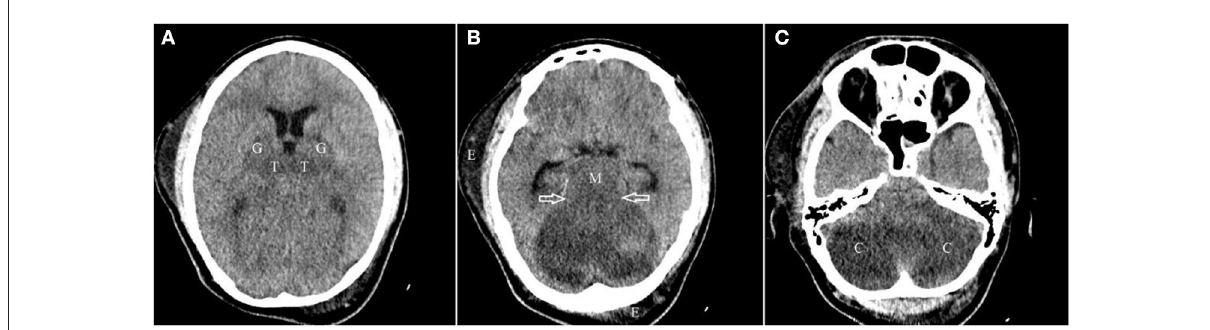
FIGURE1 Axial images of non-contrast brain CT scan from top to bottom (A–C) demonstrate near symmetric hypodensity involving both thalami (T) and globi pallidi (G), bilaterally, midbrain (M) and both cerebellar hemispheres (C) with evidence of ascending transtentorial herniation [hallow arrows in (B) ]. Subcutaneous edema (E) in right temporal and left occipital regions are also